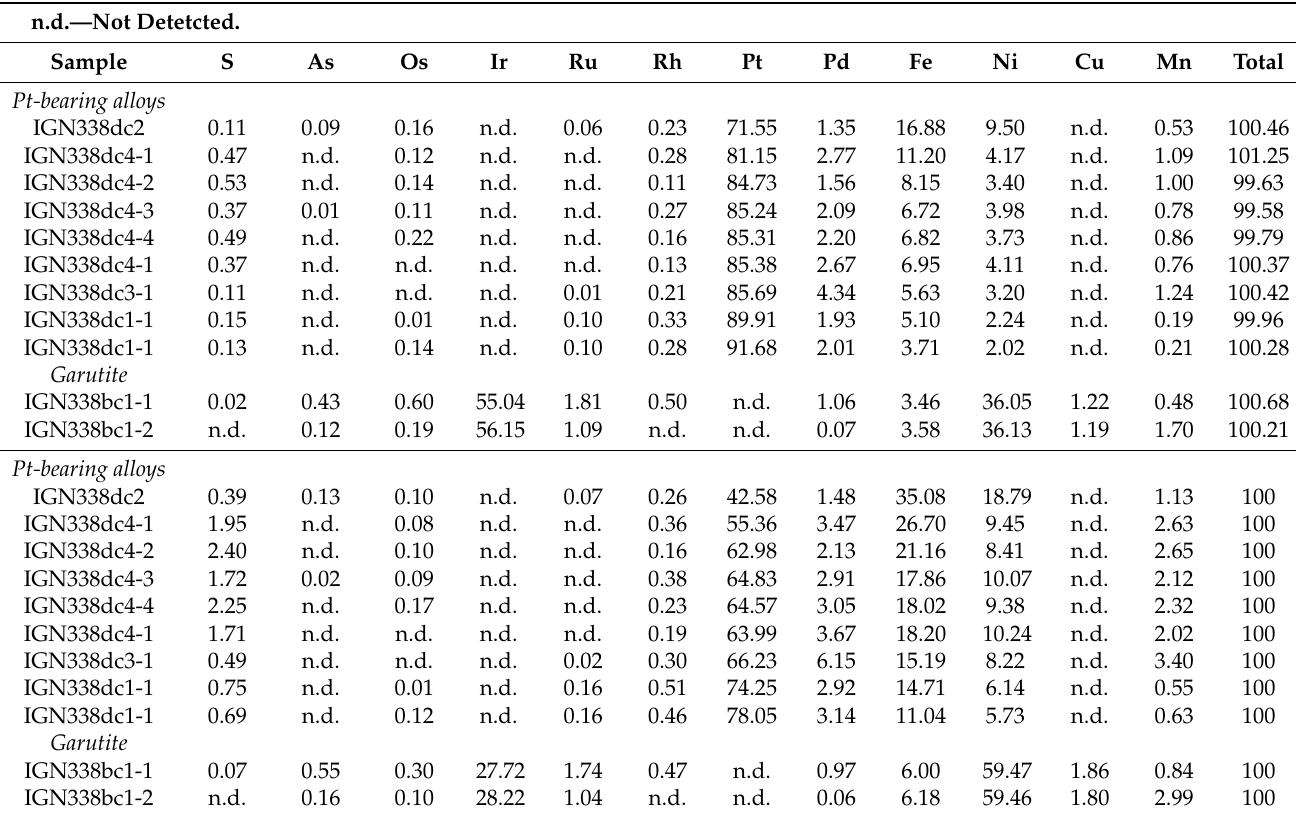
Table 7. Electron microprobe analyses (wt and at %) of Pt-bearing alloys and garutiite from High-Al Chromitite of Sebuku